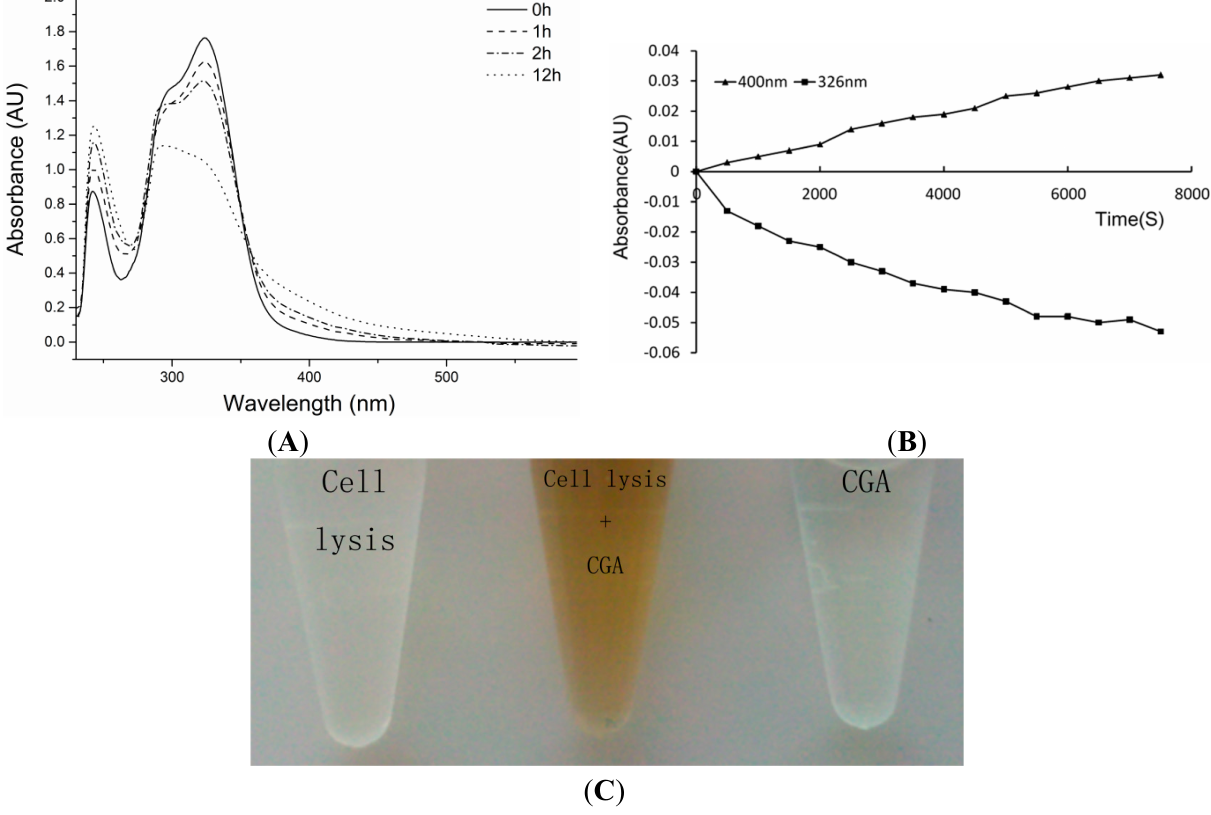
Figure 4. ( A ) Absorption spectra of CGA (0.5 mM) incubated with lytic solution (20 U/mL) at different incubation times; ( B ) Monitoring absorbance at 326 nm and 400 nm in time during incubations of CGA (0.5 mM) with lytic solution (20 U/mL); ( C ) CGA (0.5 mM) with lytic solution (20 U/mL) incubate 24 h in 37